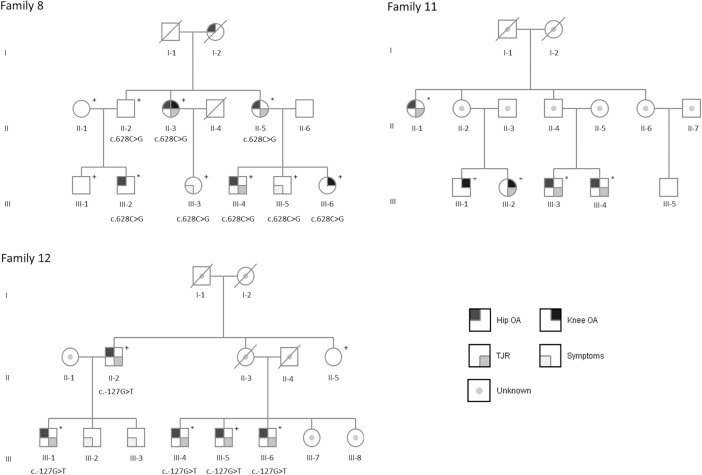
Pedigrees of Families 8 and 12.The patients included in whole exome sequencing are marked with an asterisk and individuals included in genotyping are marked with a plus symbol. Deceased are marked with diagonal line through symbol. In Family 8 the carriers of the OLIG3 variant c.628C>G, p.Arg210Gly are marked with c.628C>G. In Family 12 the observed variant c.-127G>T is located on the FIP1L1 gene 5’UTR. Abbreviations: Hip OA = Osteoarthritis of the hip, Knee OA = Osteoarthritis of the knee, TJR = Total joint replacement surgery, Symptoms = Individual has no OA diagnosis, but experiences pain and/or joint stiffness.